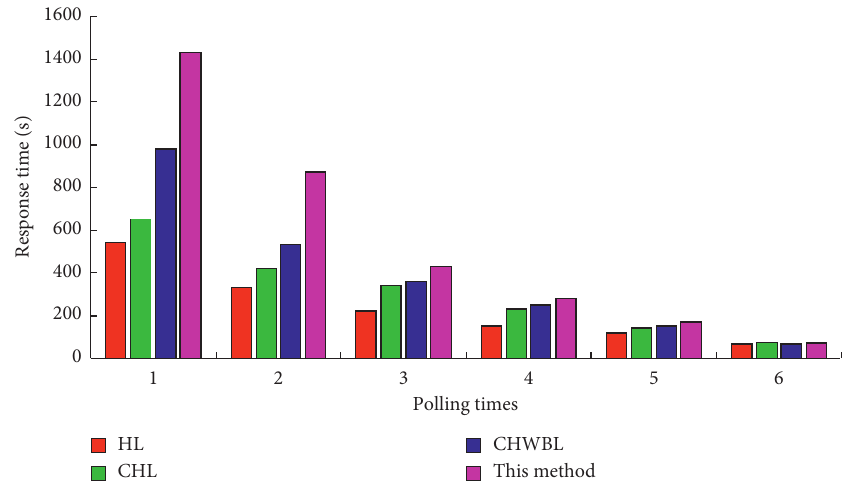
Figure 11: Comparison results of resource request response time under different